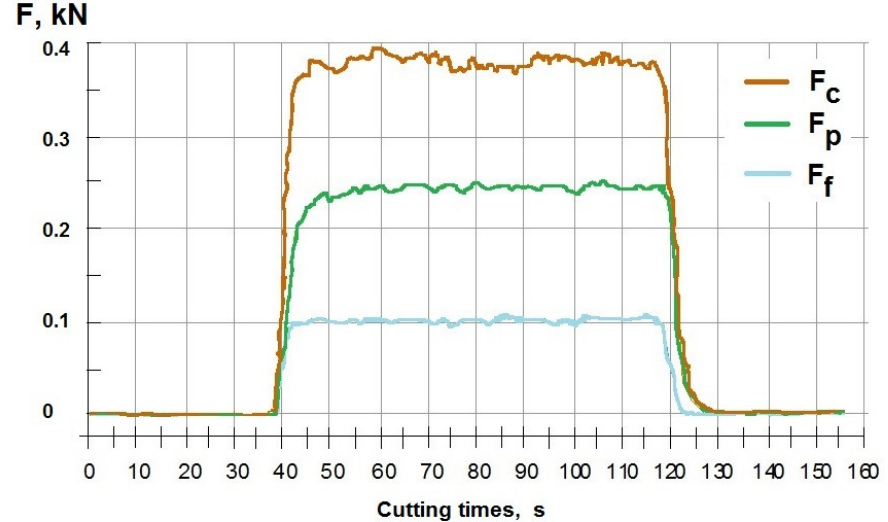
Figure 3. VB—flank wear and KB—rake face wear for samples DSS after turning.